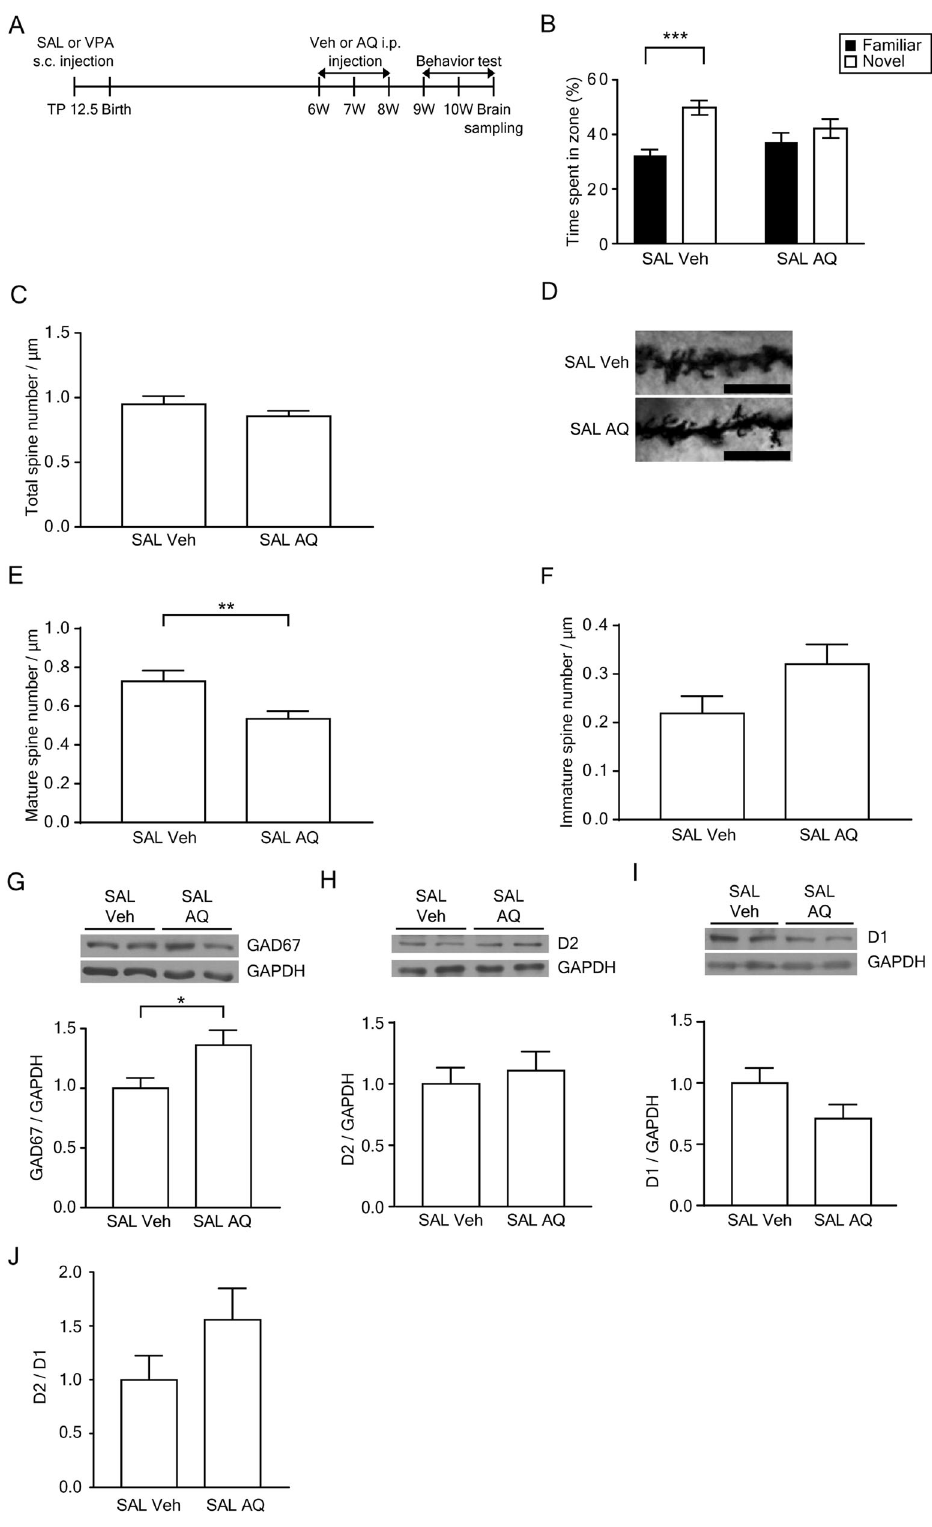
the SAL and VPA mice injected with vehicle or AQ. AQ injection in SAL mice signi fi cantly increased GAD67 expression ( p = 0.021) (Fig. 5G). D2 and D1 expression levels and the relative expression level of D2 compared to D1 ( p = 0.095) were not signi fi cantly different (Fig. 5H –